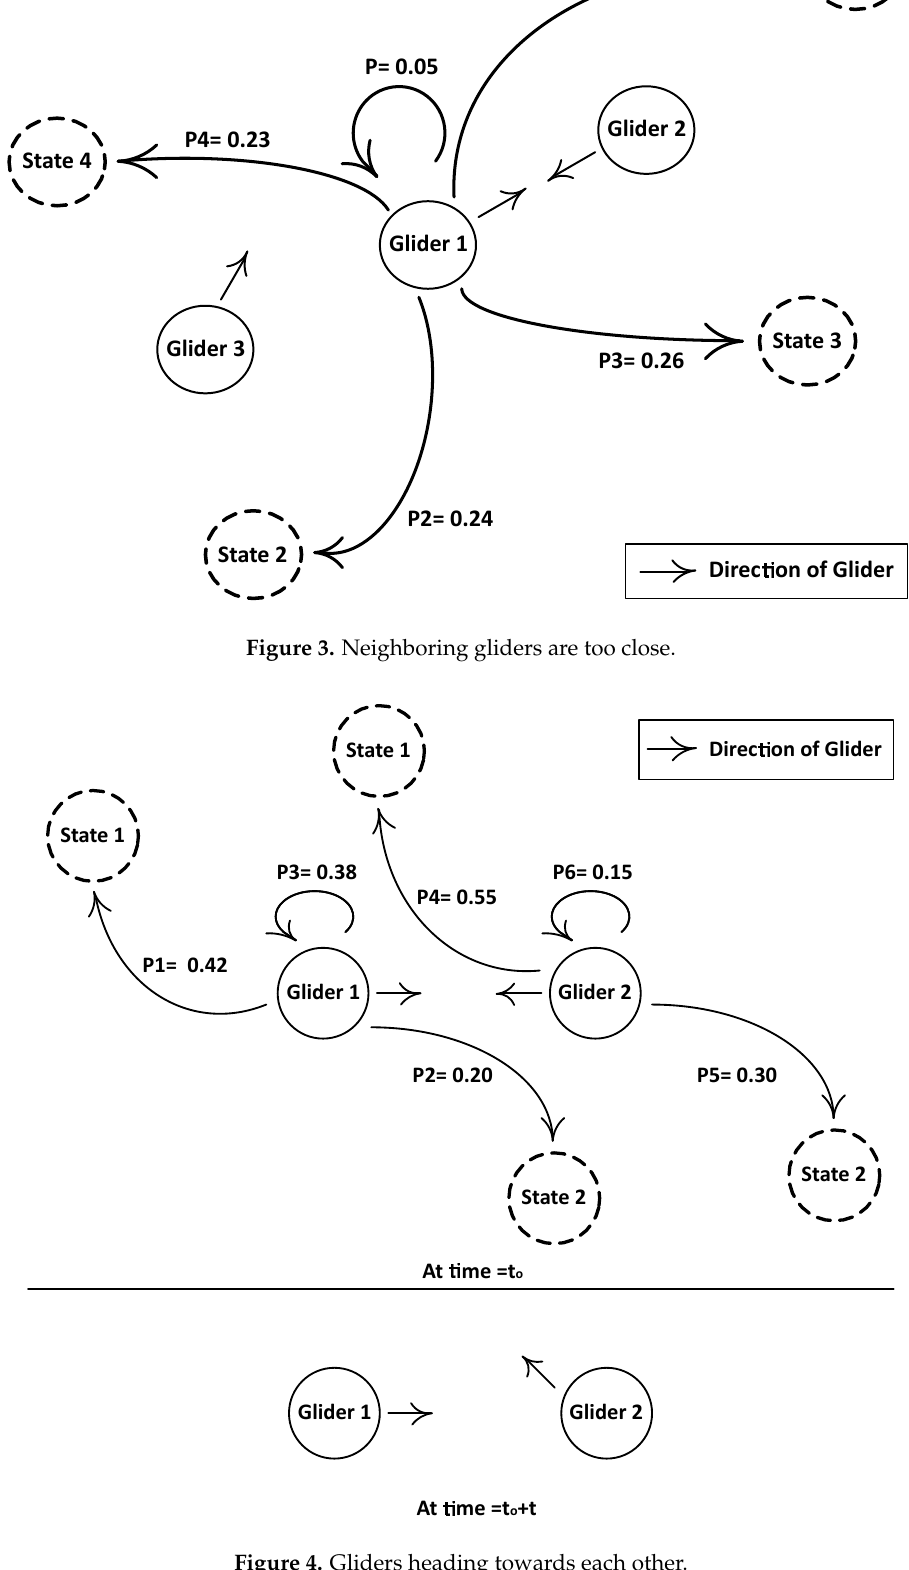
Figure 4. Gliders heading towards each